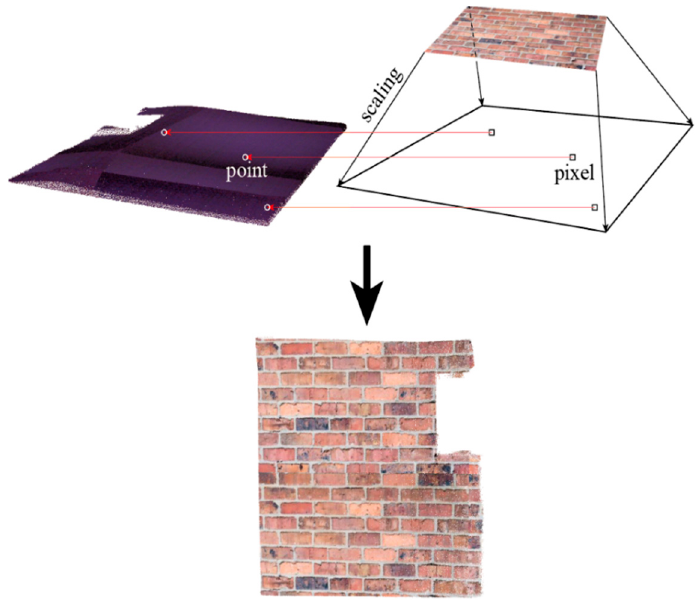
Figure 5. The proposed point ‐ to ‐ pixel